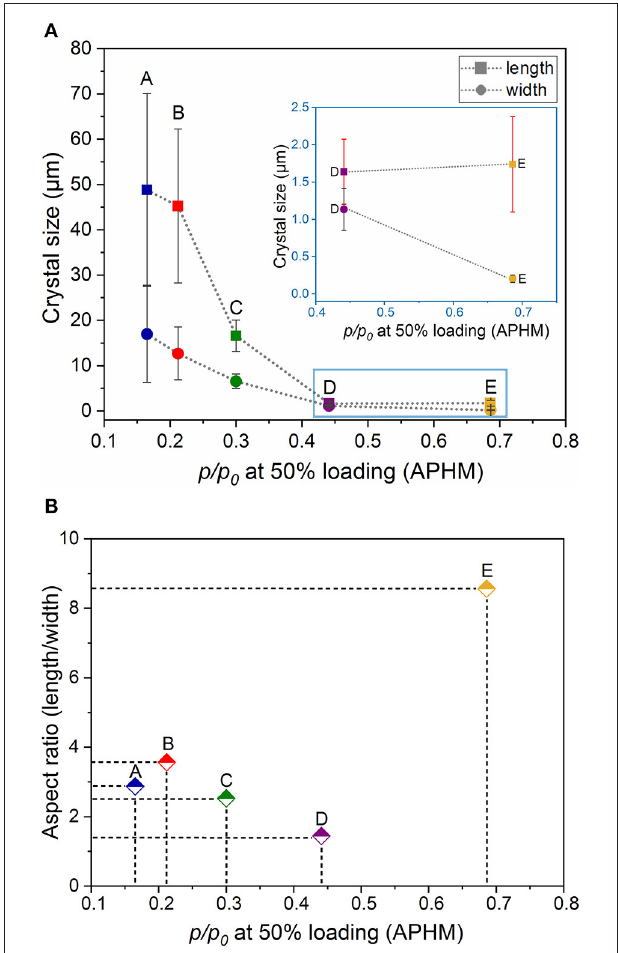
FIGURE 4 | Relationship between the relative adsorption pressure at half maximum uptake (APHM) and the crystal dimensions (length and width) (A) and shape (aspect ratio) (B)